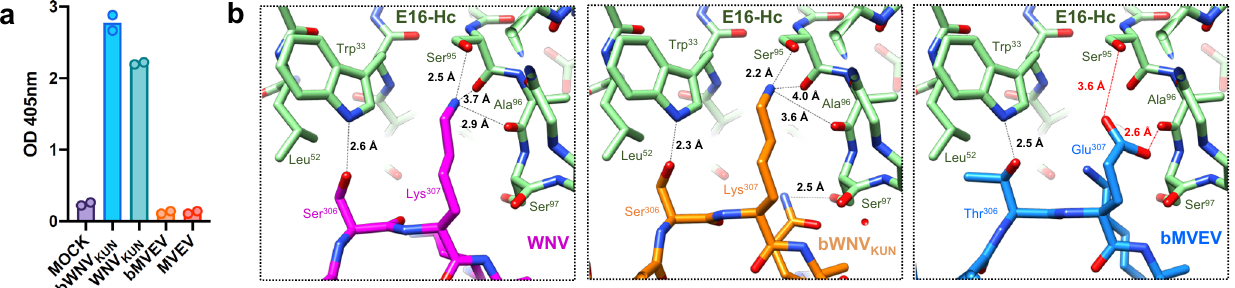
Fig. 6 Recognition of WNV KUN and bMVEV by monoclonal antibody E16. a E16 binding is virus-speci fi c with no recognition of MVEV- or bMVEV-infected cells observed at 1 µ g/mL. The bar graph represents the average OD from two technical replicates. b Structure of the WNV complex with E16 (left, PDB: 1ZTX) is compared to models of the bWNV KUN -E16 (middle) and bMVEV-E16 complex (right). The structures of bWNV KUN and bMVEV were aligned to WNV without minimization of either component. Red lines indicate clashes.